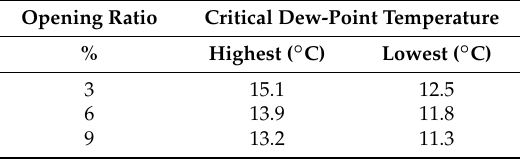
Table 4. The opening ratio and the critical dew-point temperature.